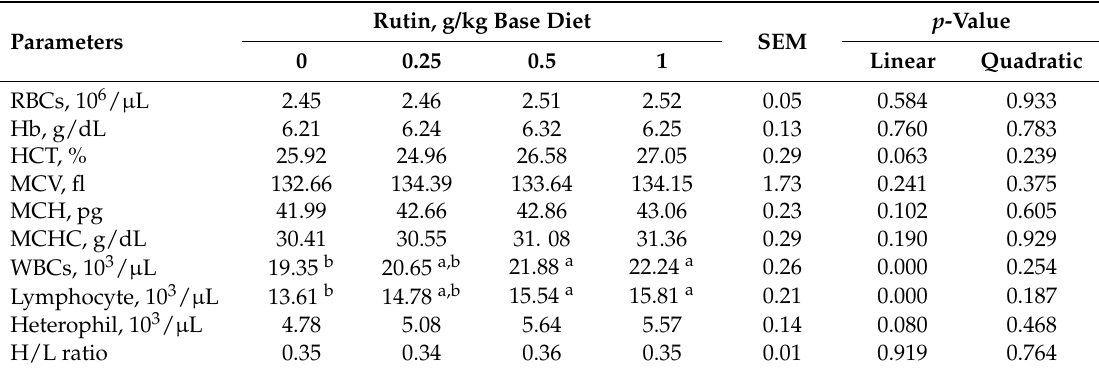
Table 4. Effect of dietary rutin on the hematological parameters of broiler